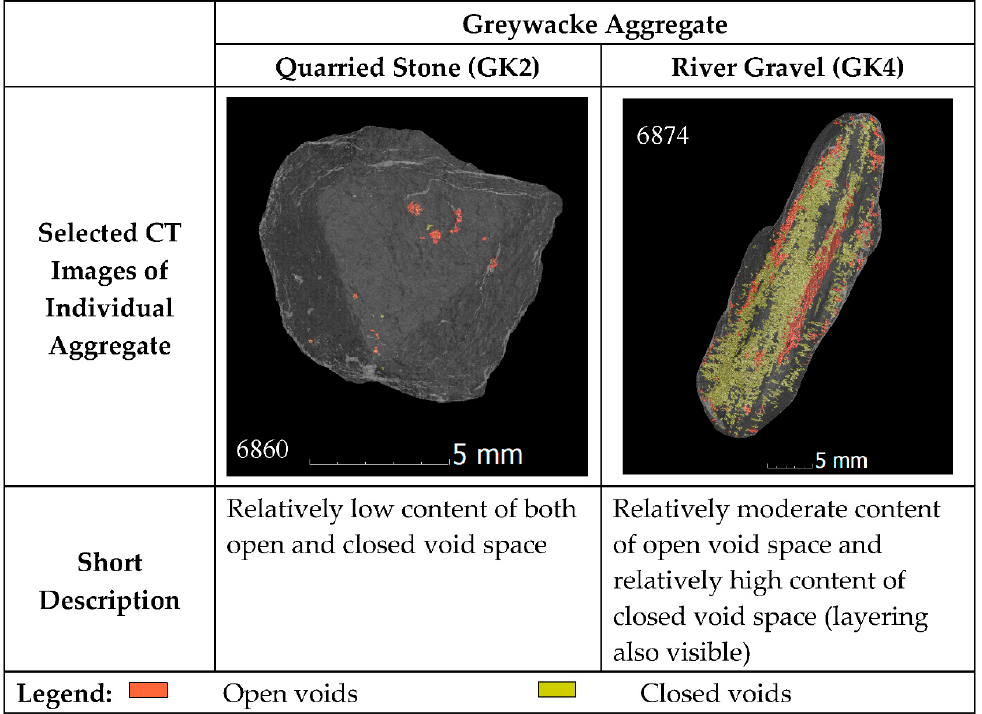
Figure A3. CT-visualizations for individual greywacke aggregate from quarried stone (GK2) and river gravel (GK4) (based on figures in [10,11]).